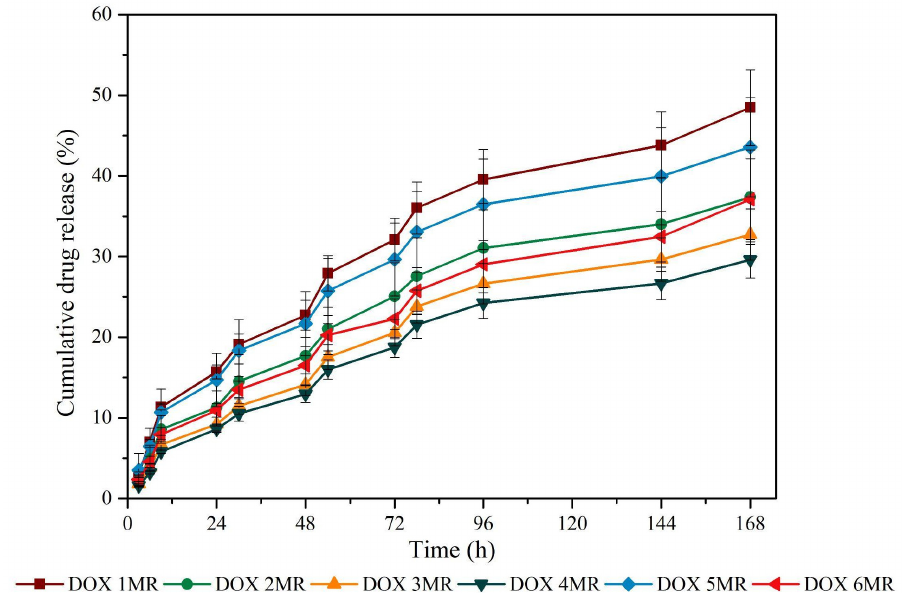
Figure 5. Release profile of all PLGA + DOX samples submitted to magnetic rotation (MR).